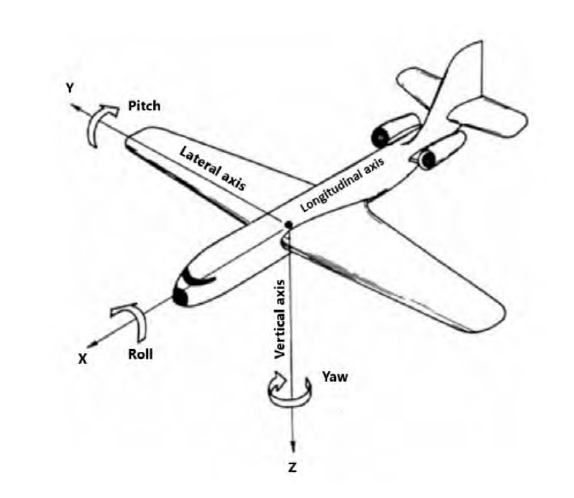
Figure 12. Drone movement